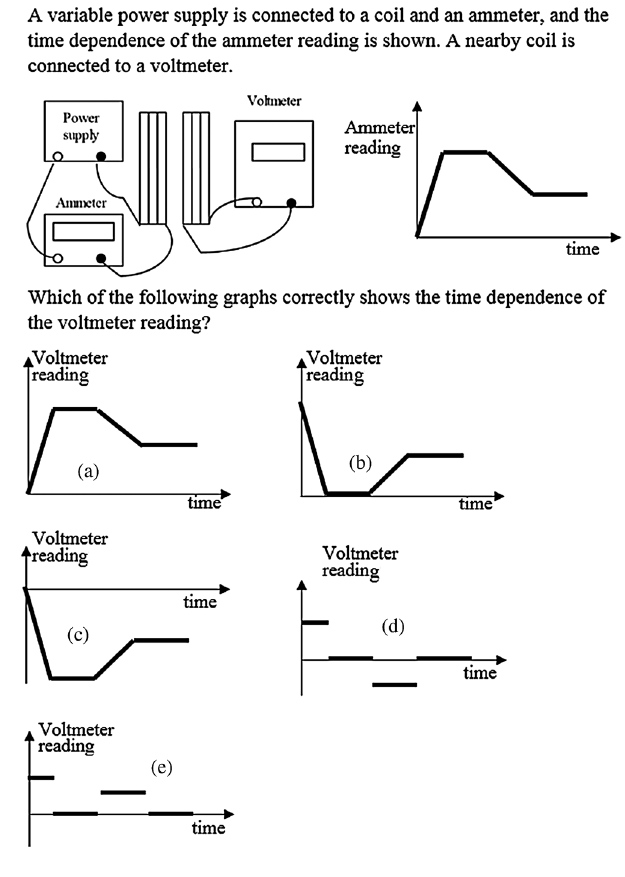
FIG. 12. Q32 on the